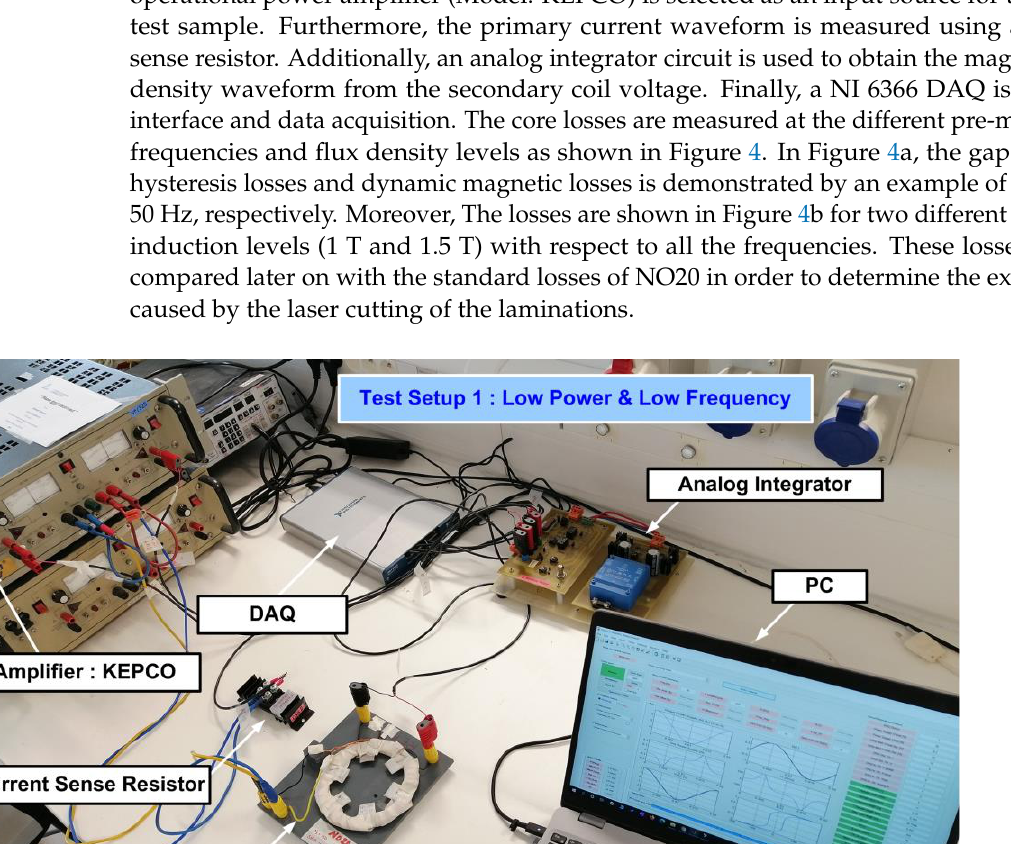
f [Hz] Figure 4. The measured core losses of the individual laminations: ( a ) with respect to magnetic flux density, ( b ) with respect to frequency. For additional verification, the same 5-lamination sample is tested at the other setup, which will be described in detail in the next part. The comparison between the results at 100 Hz is shown in Figure 5a. As can be noticed in the waveform of B(t) and H(t) , there is a very good agreement between both setups under the same operating condition of mag- netic flux density. There is also a slight mismatch between the BH loops of both setups which can be explained by the lower sensitivity of the second setup, which is designed for higher impedance loads.